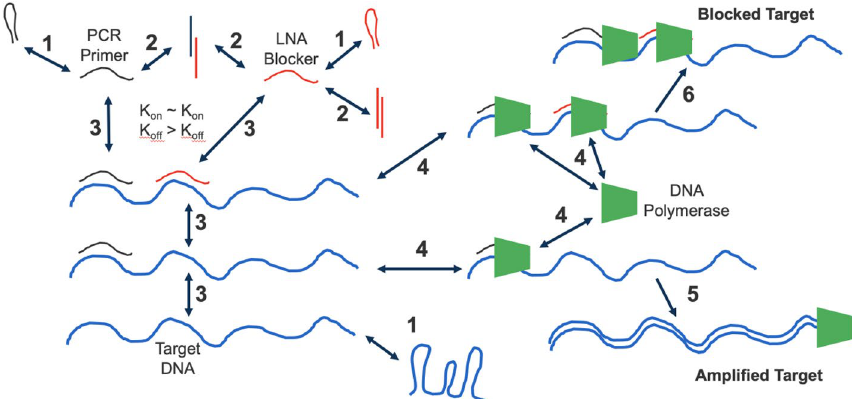
Figure 1. Potential interactions among intended reactants during PCR blockage. Potential intra- and inter- molecular interactions are shown for the PCR primer (black), the LNA blocker (red), the target DNA (blue), and the DNA polymerase (green). The DNAs/LNA can undergo folding into interfering secondary structures (1). The primer/blocker can potentially interact in a non-productive complex (2) with each other or in a productive or non-productive complex with the target DNA (3). LNAs have a slower off-rate versus DNAs 46 . The DNA polymerase can then bind the primer/blocker/target complex (4) and either extend the primer to generate an Amplified Target (5) or, if polymerization is halted by the LNA when the LNA is bound to the target DNA, a Blocked Target